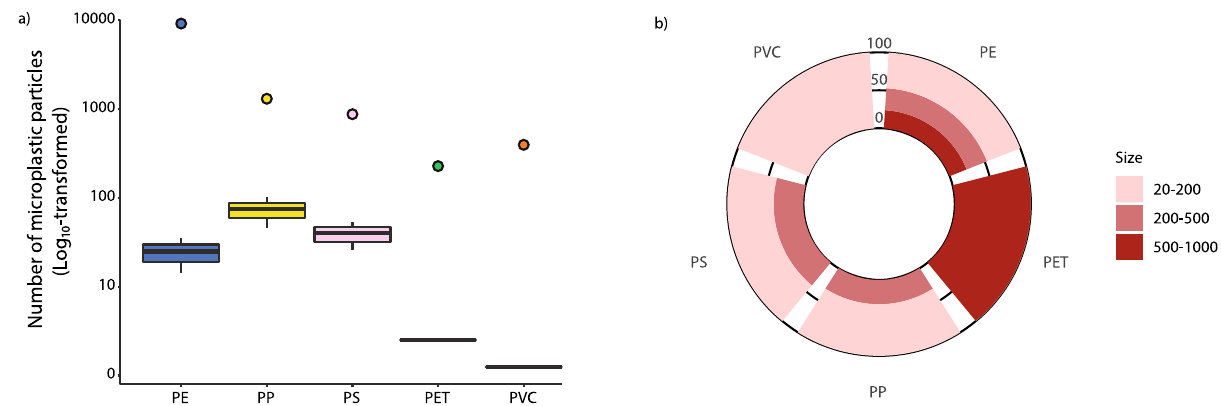
Fig. 2 Microplastic particles ingested by the red coral Corallium rubrum and their polymer composition. a Log 10 -transformed number of different microplastic polymers ingested by C. rubrum after 14 days of experiment (average number per branch) in the systems with high concentration of microplastic particles. Circles indicate the Log 10 -transformed number of each polymer added to the tanks at the beginning of the experiment. Data are represented as mean ± standard deviation ( n = 3). b Contribution (expressed as percentage) of different size of microplastics ingested by a branch of Corallium rubrum . Abbreviations of plastic polymers: PE polyethylene, PP polypropylene, PS polystyrene, PET polyethylene terephthalate,